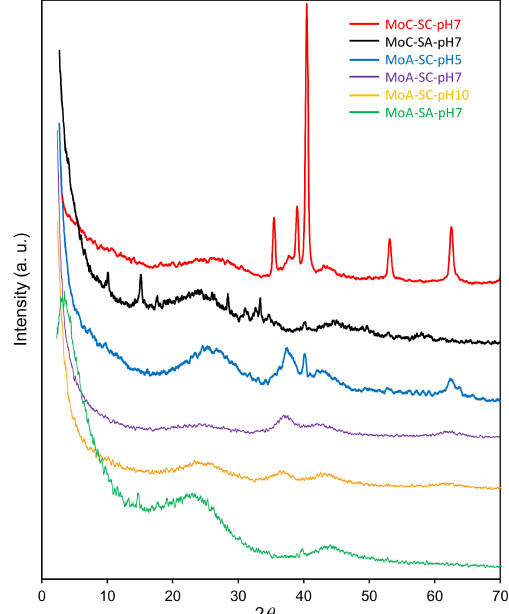
Figure 5. XRD-patterns of Mo-doped carbon